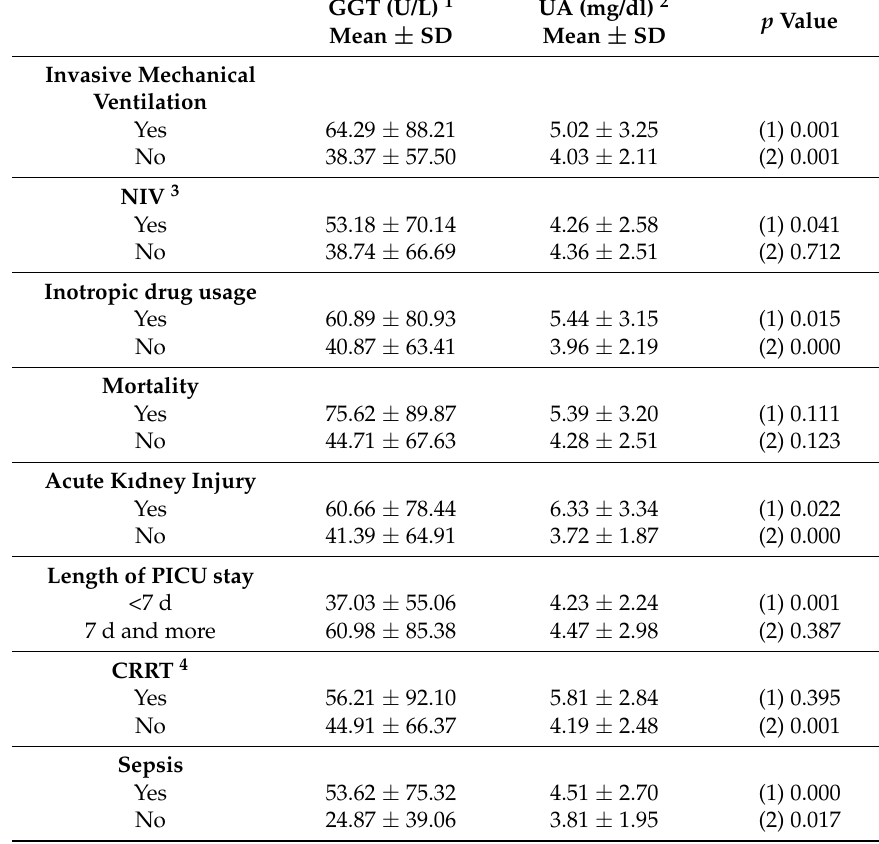
Table 2. Evaluation of prognostic factors according to gamma glutamyl transferase (GGT) and uric acid (UA) levels: 1. Gamma glutamyl transferase. 2. Uric acid. 3. Noninvasive Mechanical